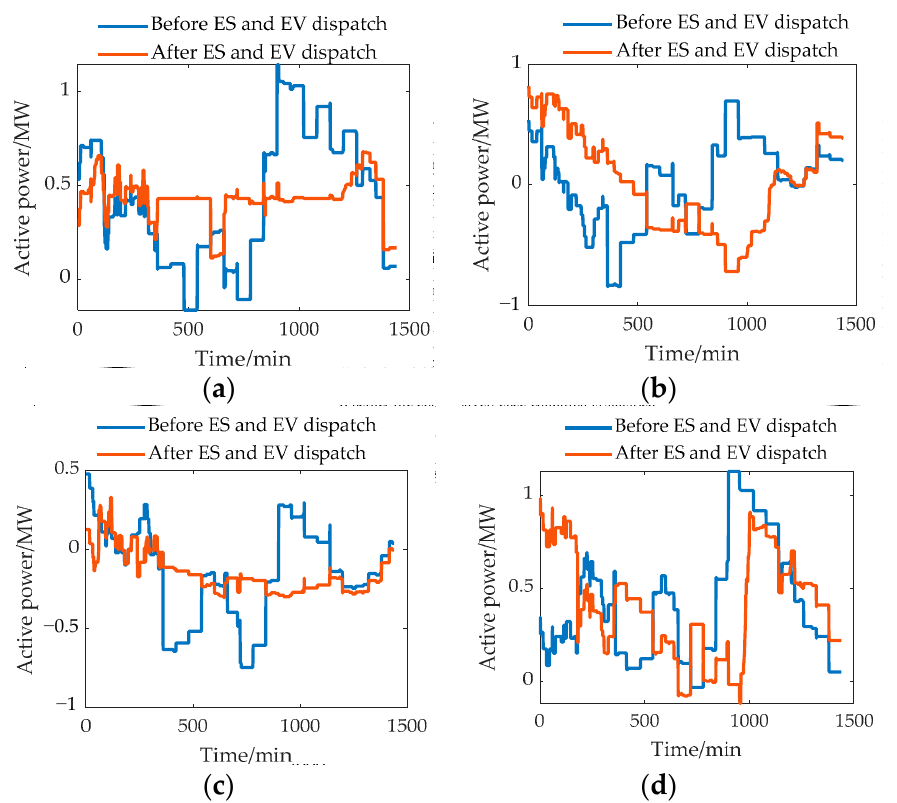
Figure 6. Load curve before and after the dispatching of ES and EV. ( a ) Spring. ( b ) Summer. ( c ) Autumn. ( d ) Winter.